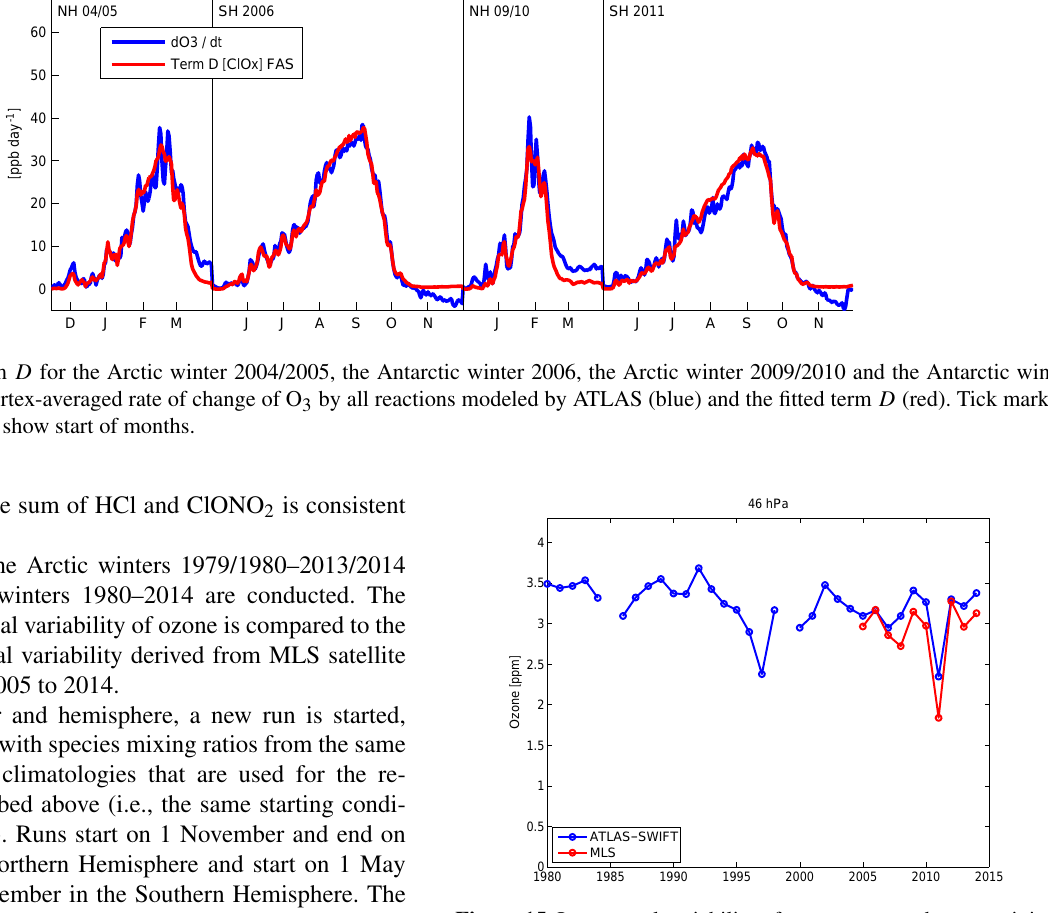
Figure 15. Interannual variability of vortex-averaged ozone mixing ratios in Arctic winter at 46hPa for Polar SWIFT (blue) and MLS (red), on the last day before vortex breakup. The date differs for different years due to different dates of vortex breakup; see Table 4.